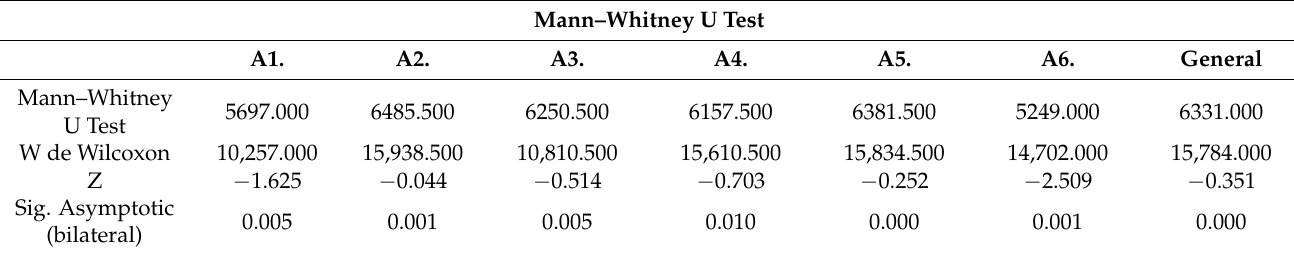
Table 6. Mann–Whitney U Test with a non- COVID-19– COVID-19grouping variable